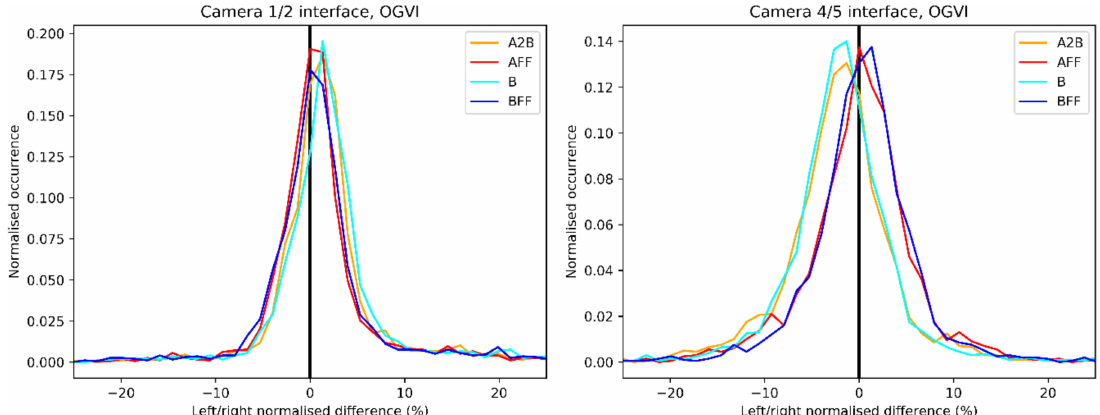
Figure 22. OGVI normalised relative di ff erences between the values obtained from the two adjacent cameras for interface 1 / 2 ( left ) and interface 4 / 5 ( right ) and for the four calibration setups. Flat-fielding e ffi ciently reduces di ff erences of OGVI at camera interfaces.